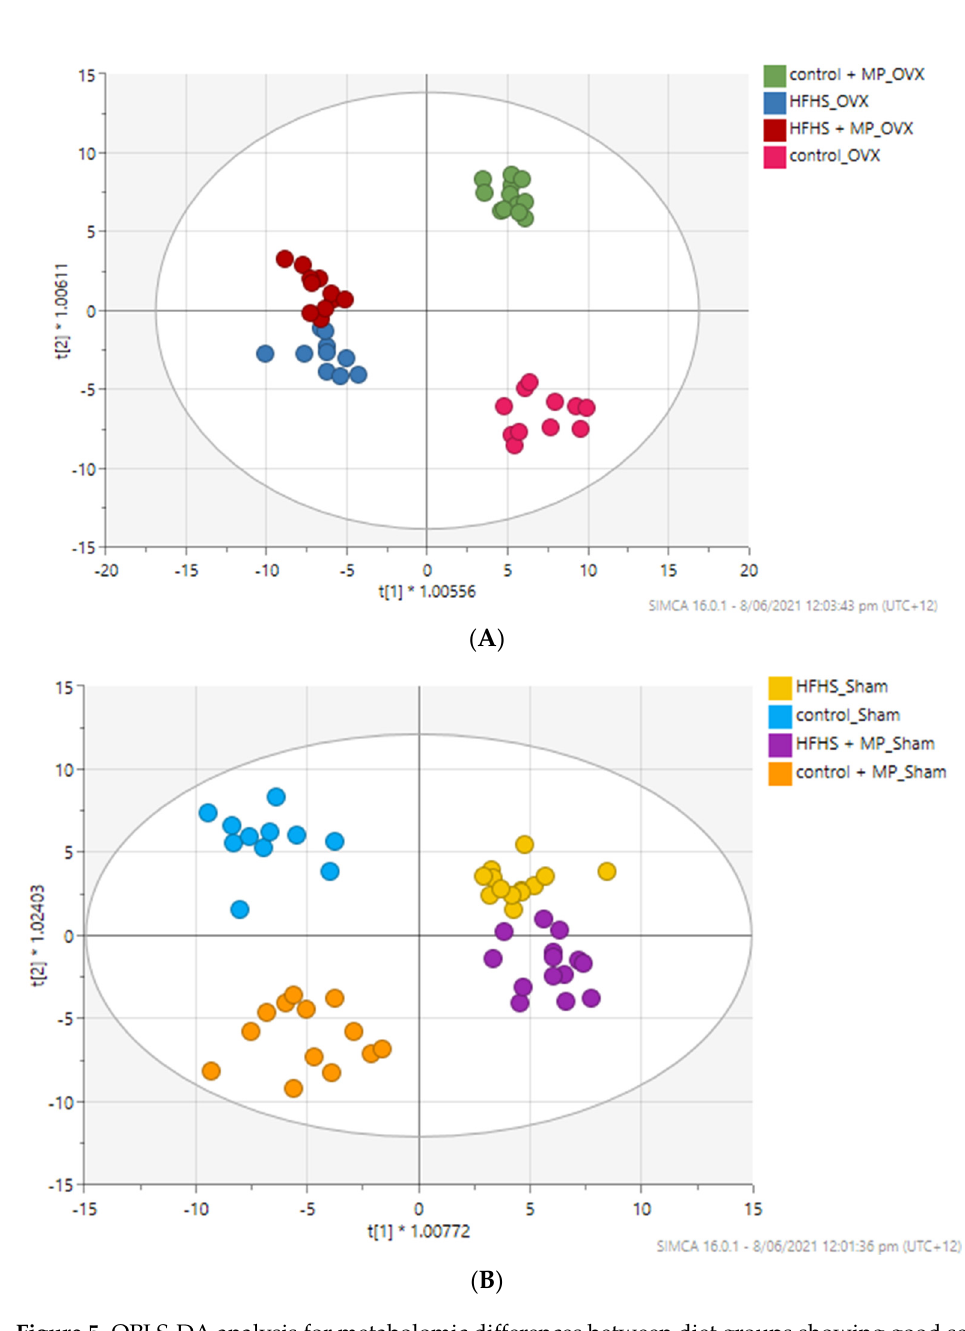
Figure 5. OPLS-DA analysis for metabolomic differences between diet groups showing good sepa- ration and robust modelling for sham and OVX rats; MP = greenshell mussel powder included in diet. Each circle represents the metabolite profile of single rat. ( A ) OPLS-DA scoring plot showing discrimination between diets groups in OVX rats ( n = 44); R2X (cum) = 0.445, R2Y (cum) = 0.891, Q2 (cum) = 0.572. Cross-validated ANOVA p -value = 5.30302 × 10 -5 . ( B ) OPLS-DA scoring plot showing discrimination between diets groups in sham rats ( n = 51); R2X (cum) = 0.307, R2Y (cum) = 0.624, Q2 (cum) = 0.401. Cross-validated ANOVA p -value = 1.32627 × 10 -4 .